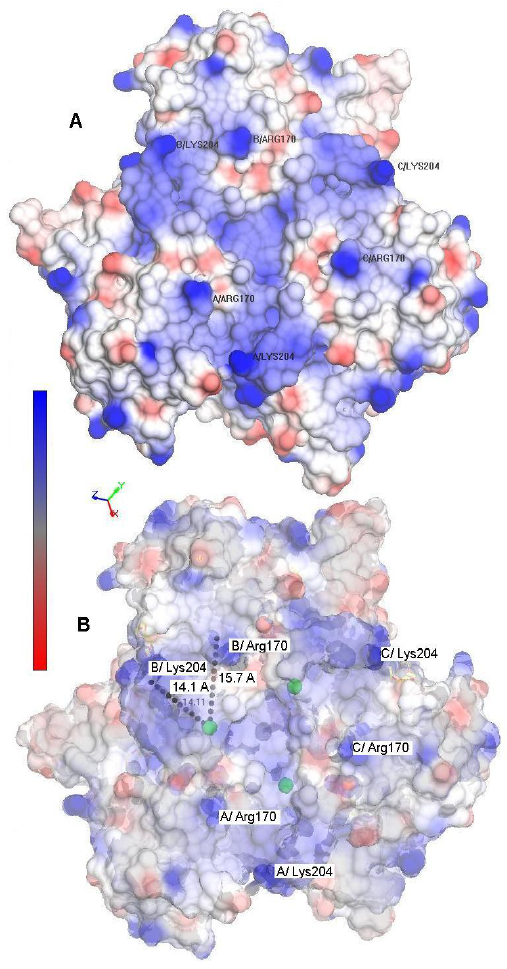
Figure 3. ( A ) Surface electrostatic potential of the homo-dimeric Streptomyces coelicolor small laccase (SLAC) showing neutral (white), positively (blue) and negatively (red) charged areas. The three monomers are labeled A, B, and C. The figure was prepared using the NOC 3.01 package from the X-ray structure (PDB code 3CG8) [42]. ( B ) Schematic representation of SLAC with a decreased opacity. The T1 copper ions are depicted as green dots. The Arg170 and Lys204 residues for all subunits are highlighted. The distances form the T1 copper center to the selected residues of subunit B are calculated from the crystallographic structure.